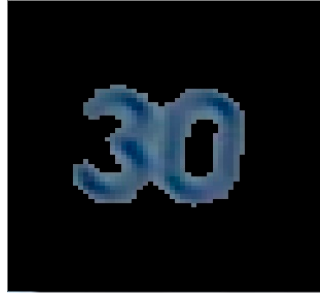
Figure 12. When two numbers are combined and detected as a single area.